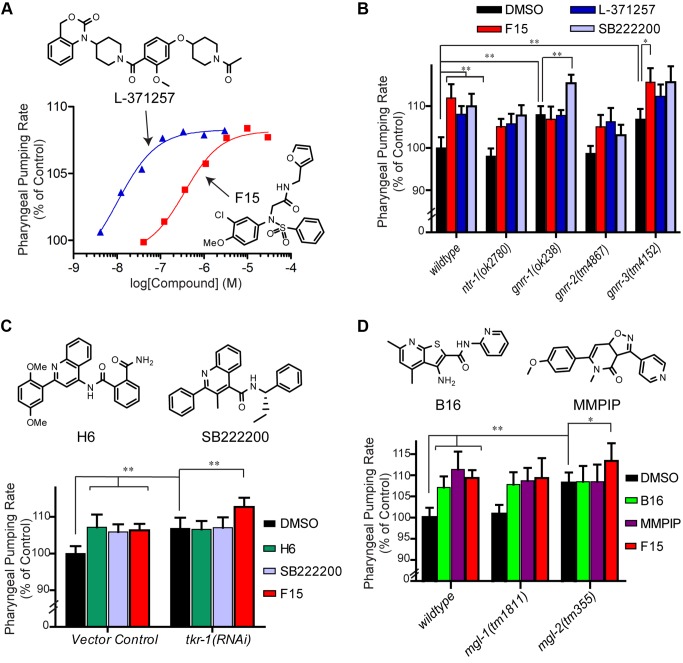
Identification of C. elegans GPCR-regulated feeding pathways that are pharmacologically orthologous to their human targets.(A) Wild-type C. elegans treated with serial 3-fold dilutions of either F15 or L-371257. Error bars represent the standard error of the mean. (B) Wild-type, ntr-1(ok2780), gnrr-1(ok238), gnrr-2(tm4867), or gnrr-3(tm4152) mutant animals cultured on either 0.1% DMSO, 10 µM F15, 100 nM L-371257, or 200 nM SB222200. (C) Wild-type C. elegans cultured on E. coli expressing either tkr-1 RNAi or vector control, then treated with either 0.1% DMSO,10 µM H6, 10 µM F15, or 200 nM SB222200. (D) Wild-type, mgl-1(tm1811), and mgl-2(tm355) mutant C. elegans cultured on media containing either 0.1% DMSO, 10 µM B16, 10 µM F15, or 2 µM MMPIP. Error bars represent the standard deviation. (A–D) The mean pharyngeal pumping rate of 10–20 C. elegans per condition are shown. Significance levels: **p<0.001, *p<0.05 were determined by one-way ANOVA using Bonferroni's multiple comparison test.